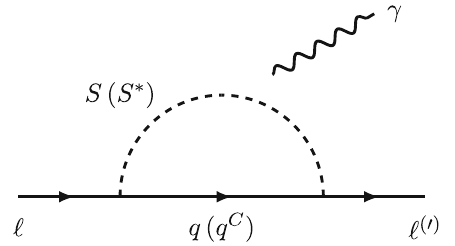
Fig. 4 One-loop diagram contributing to the charged leptons anoma- lous magnetic moments and the flavor changing process (cid:15) → (cid:15) (cid:6)